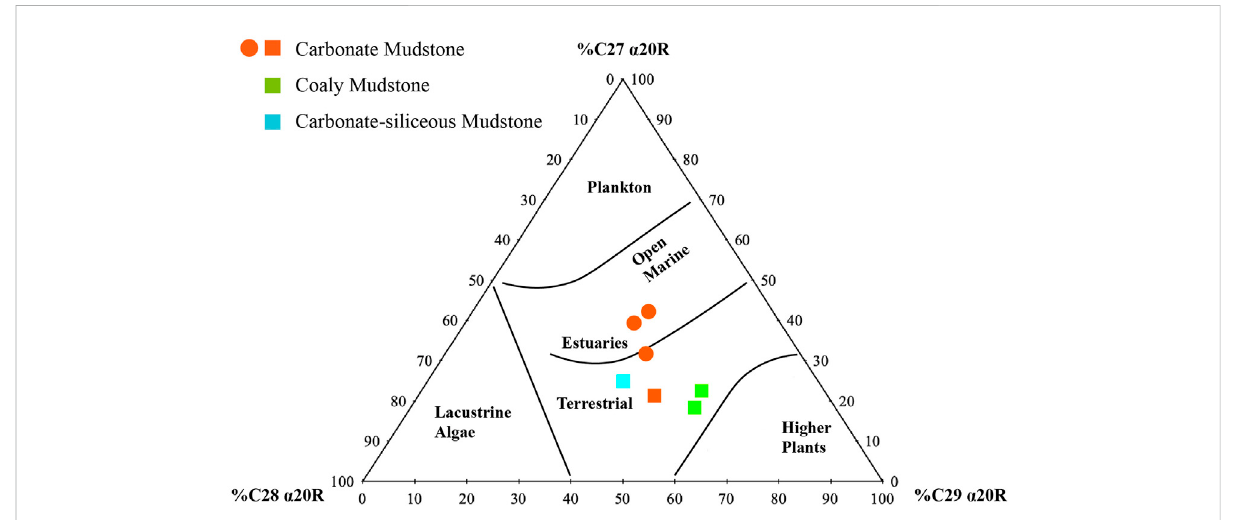
FIGURE 10 Ternary diagram of relative abundance of C27, C28, and C29 regular steranes showing the sources and depositional environments of the samples from the Huai Hin Lat Formation. The red rectangle, green rectangle, and blue rectangle represent the samples from location A, while the red dot denotes the samples from location